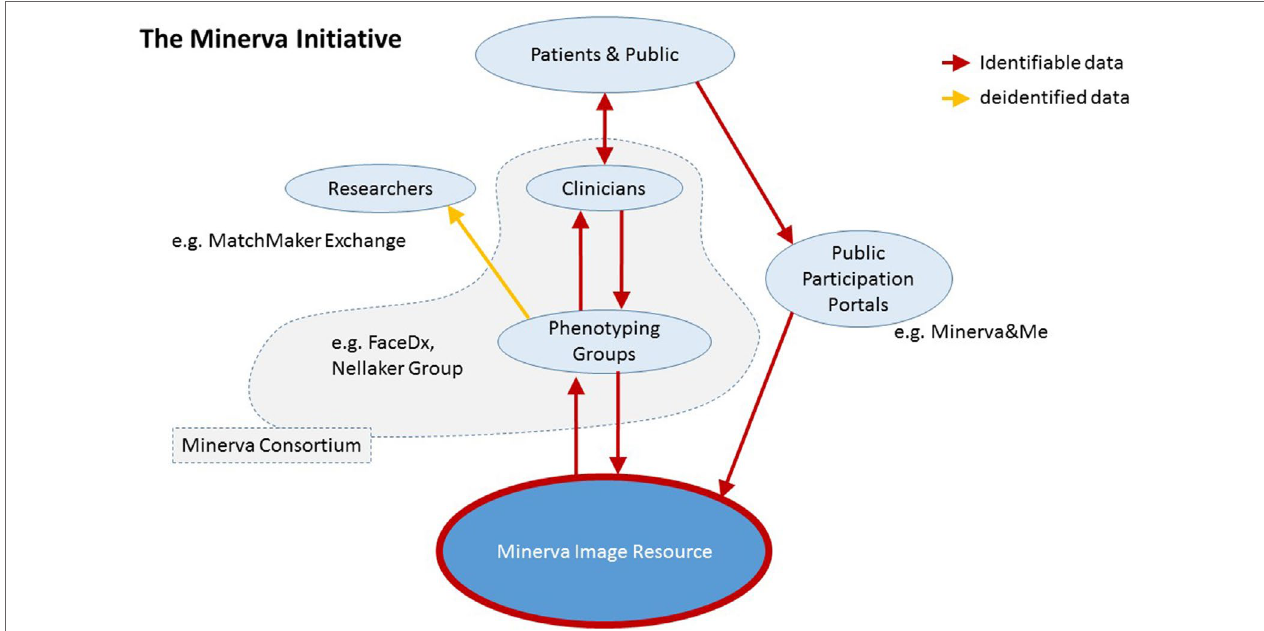
FIGURE 1 | Schematic overview of the Minerva Initiative structure and data flow into the Minerva Image